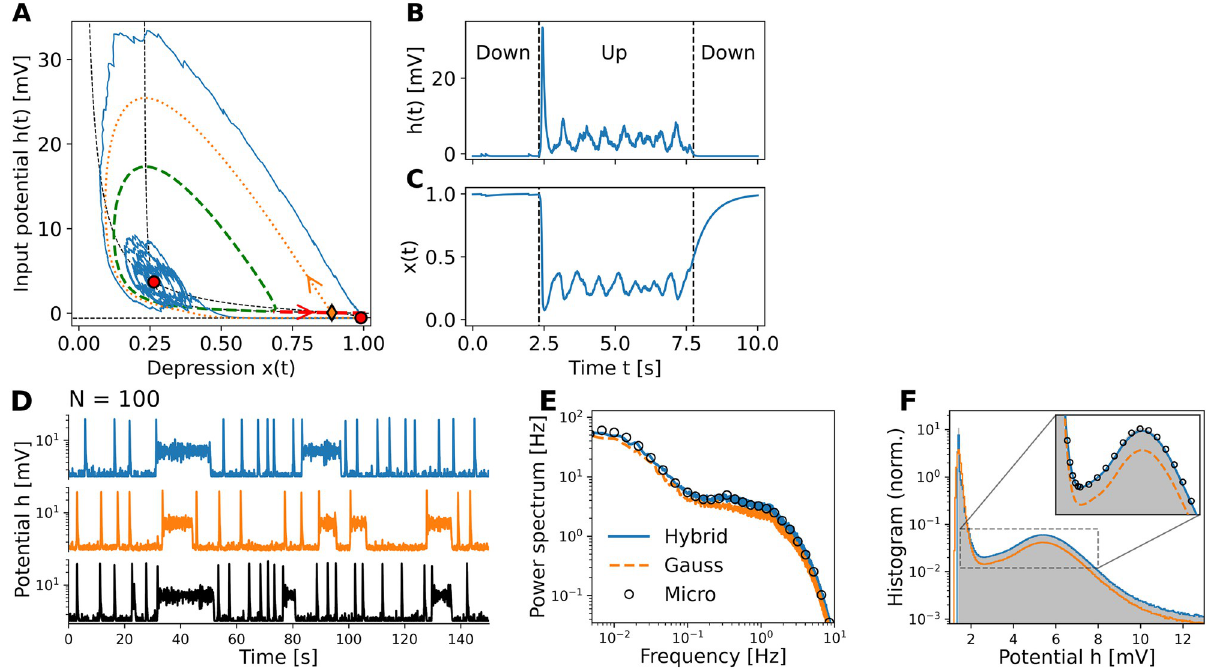
Fig 3. Up-down dynamics due to finite-size fluctuations. Mesoscopic model reproduces noisy bistable population dynamics. (A) Phase-plane analysis of macroscopic dynamics (Eq (3) for N ! 1 ) reveals two stable fixed points (red): a high-activity focus representing the Up, and the low-activity node the Down state of the system. From the saddle fixed point (orange diamond), an unstable (orange dotted line) and a stable manifold (red dashed line) emerge. The latter acts as a separatrix—trajectories (blue curve) starting from above make an excursion around the unstable limit cycle (green dashed) and converge towards the down state. Finite-size fluctuations can make the trajectory cross the limit cycle into the basin of attraction of the Up state. (B, C) Stochastic trajectory of the mesoscopic dynamics (3) with N = 100 transitioning between Down and Up states. (D) The mesoscopic models with hybrid noise (jump-diffusion model; blue) and Gaussian noise (diffusion model; orange) qualitatively capture Up-Down-dynamics of the microscopic network (black). (E) Power spectrum and (F) histogram of input potential h over simulation of length T sim = 100 0 000s. Model parameters can be found in Table